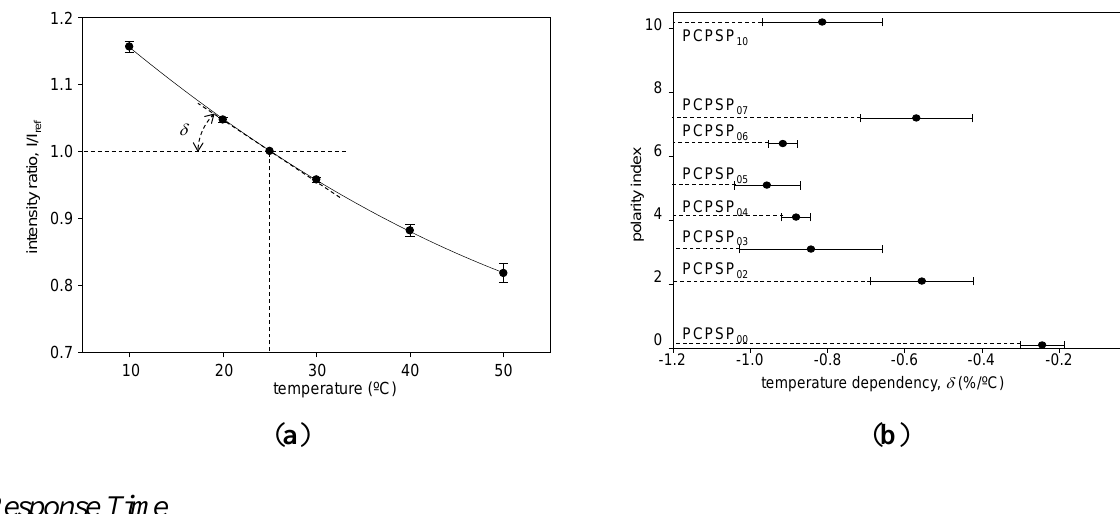
Figure 9. ( a ) The temperature calibration of PCPSP temperature dependency,  (%/  C), and the polarity